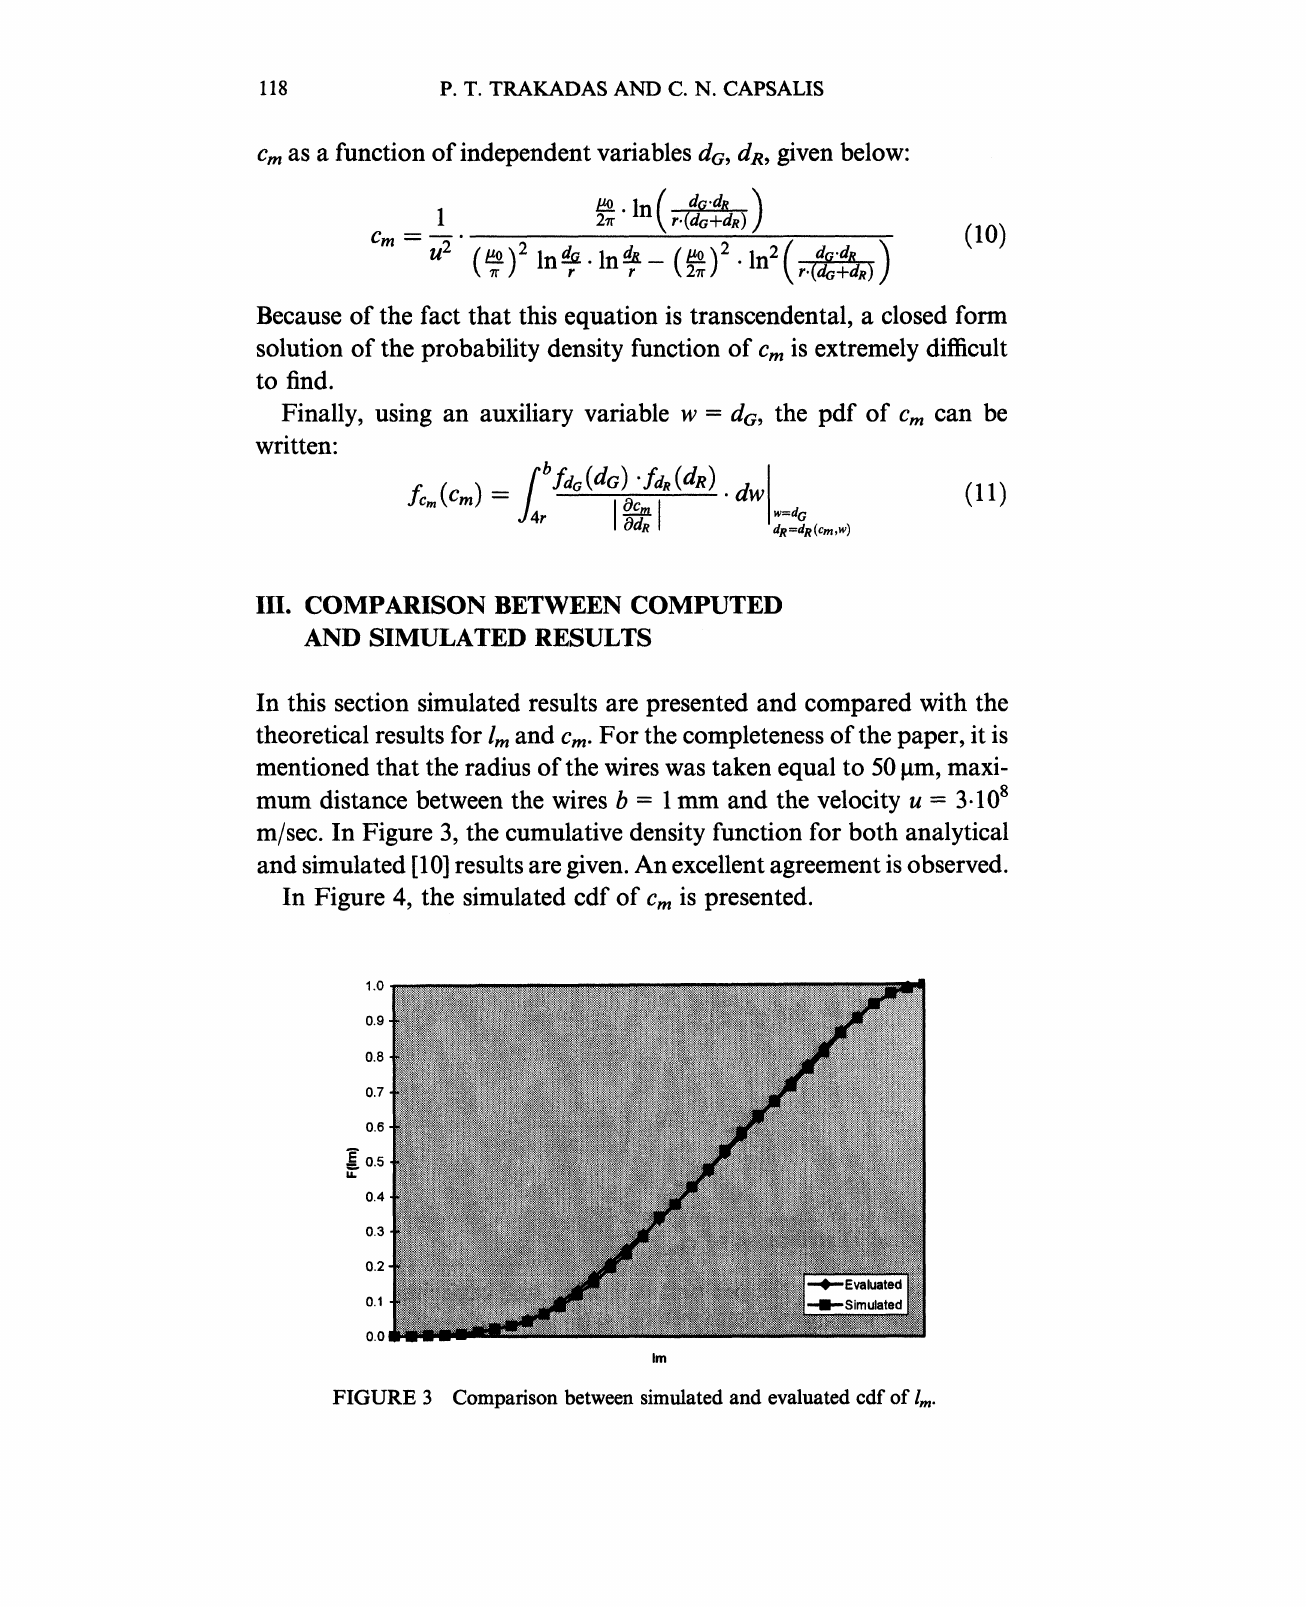
FIGURE 3 Comparison between simulated and evaluated cdf of